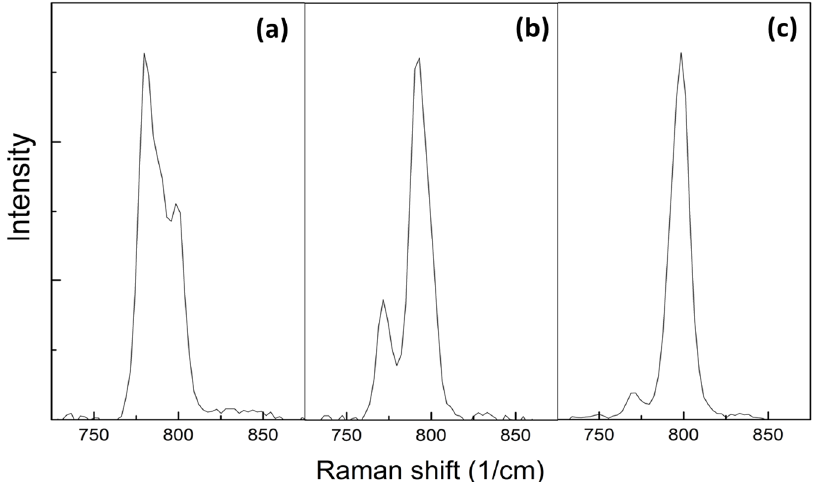
Figure 9. Details of the TO peaks for the SiC matrix of the novel preceramic paper ‐ derived SiC f /SiC Composites by sintering at 2100 °C for 3 min ( a ); matrix with other sintering conditions ( b ); and SiC fiber ( c ).